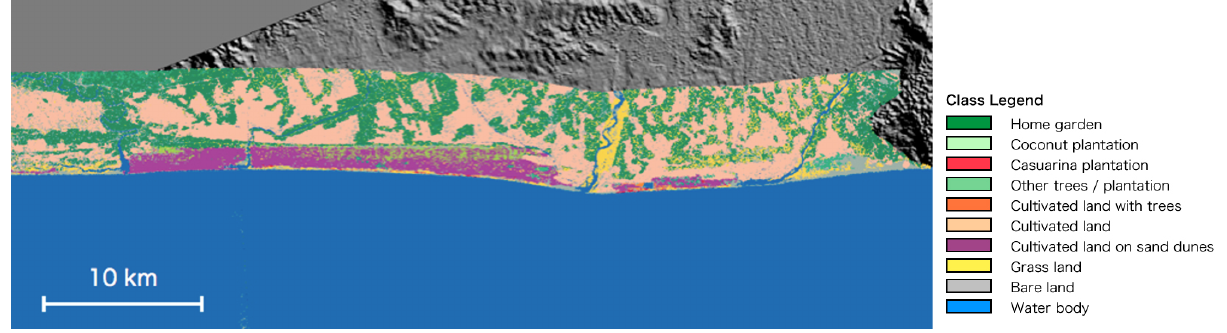
Fig. 6. Land cover/Land use classification using satellite imagery.